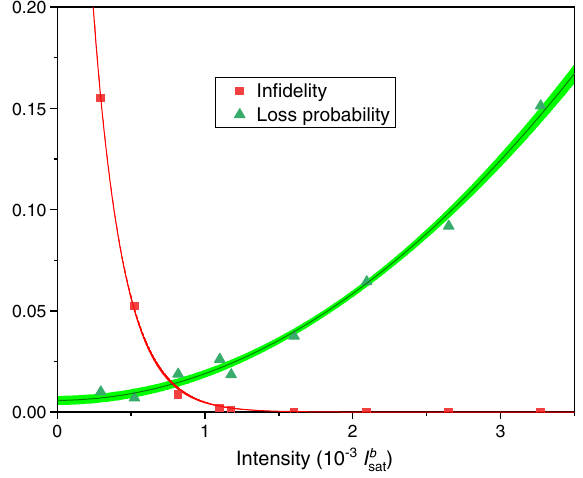
FIG. 9. Infidelity and loss probability for an image of duration 120 ms, with variable power in the 399 nm imaging beam. I b 63 mW = cm 2 is the saturation intensity of the transition at 399 nm. The red curve is an exponential fit to the infidelity data, and the green curve is a quadratic fit to the loss data. Both shaded regions are 1 σ confidence